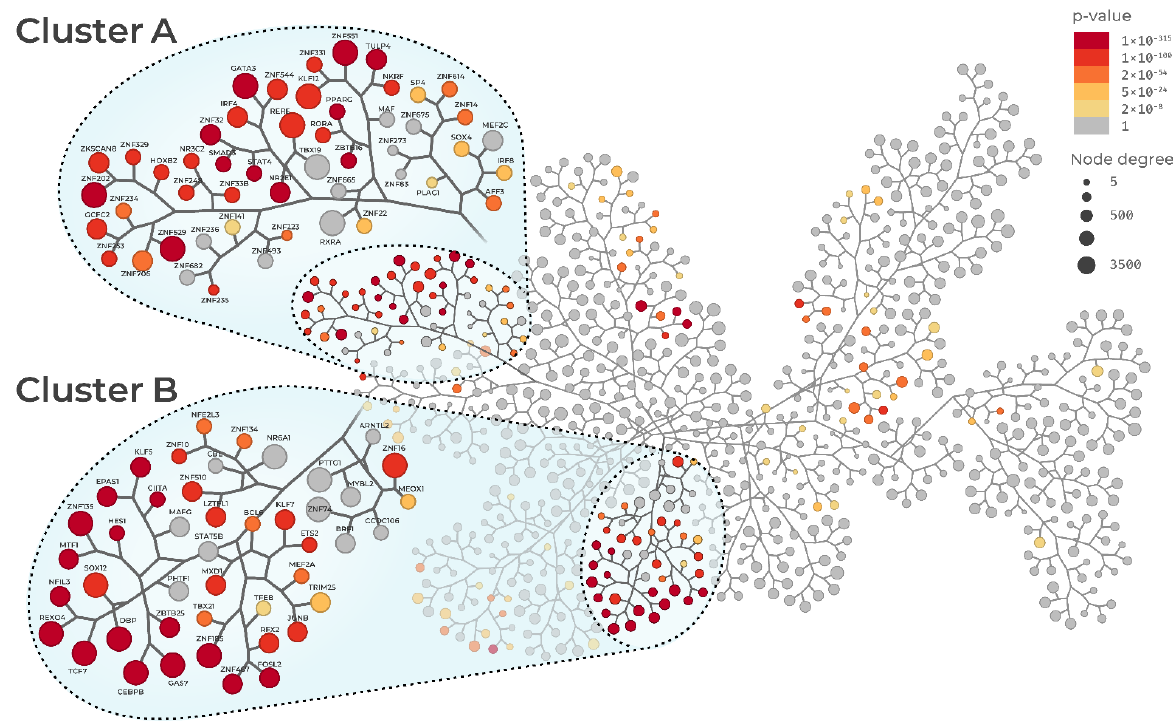
Figure 2. Tree-and-leaf representation of the Pediatric Sepsis 1 (GSE13904) regulatory network. Nodes represent regulatory units (i.e., regulons) labeled after their transcription factors. Node size represents regulon connectivity with regulated genes (degree); node color represents adjusted p -value (FDR < 0.01) of MR enrichment for sepsis condition. Dotted lines denote the two main connected clusters of regulons, cluster A and